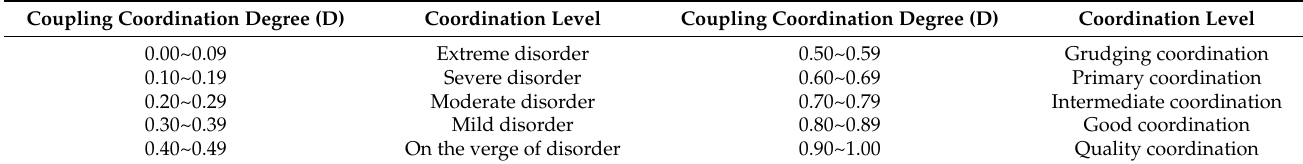
Table A2. Classification of coupling coordination